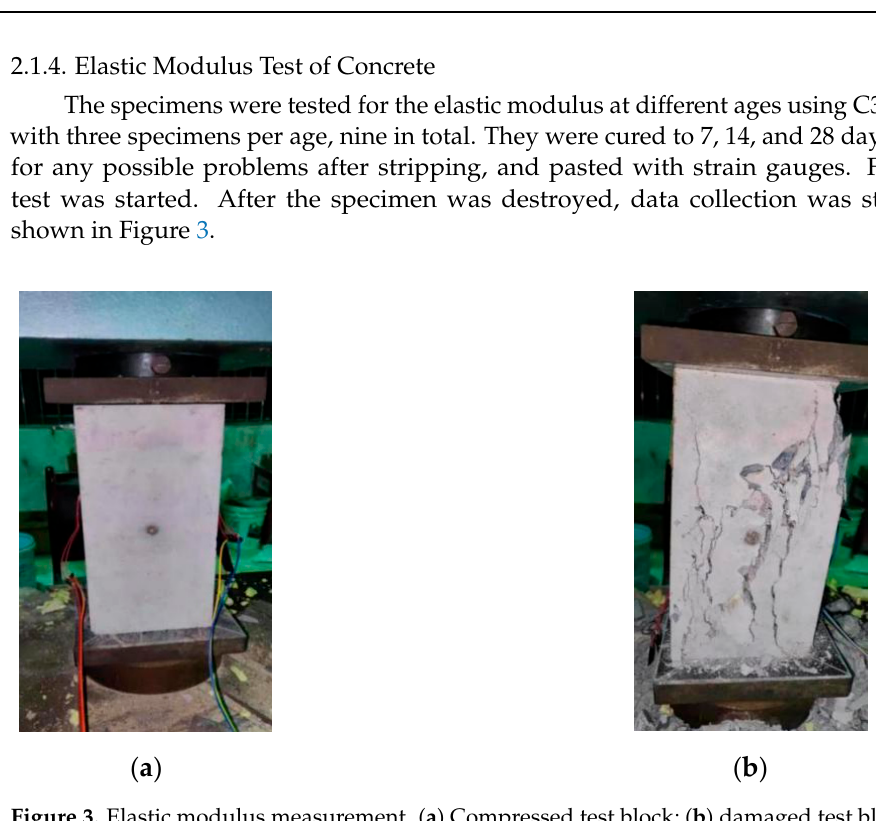
Figure 3. Elastic modulus measurement. ( a ) Compressed test block; ( b ) damaged test block.